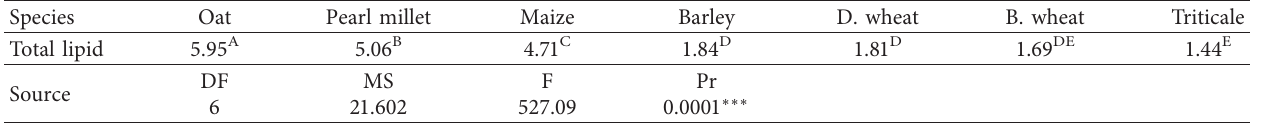
Table 3: Variation of total lipid (%) of the 7 cereal species.